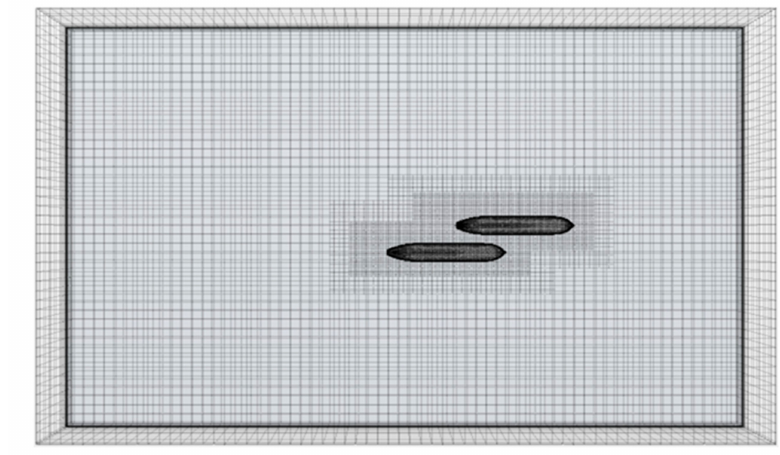
Figure 3. Vertical view of the computational domain.